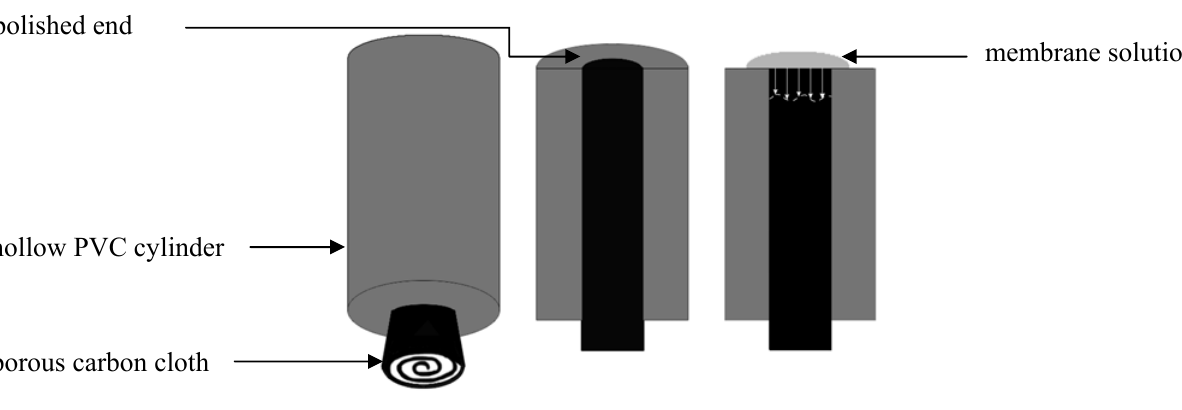
Figure 1. Schematic picture of carbon cloth-based electrodes. Left : Hollow PVC cylinder with carbon cloth in the center of the electrode; Middle : Cylinder shown from top with the polished end; Right : Cylinder shown with membrane solution that has been placed on the top of the polished